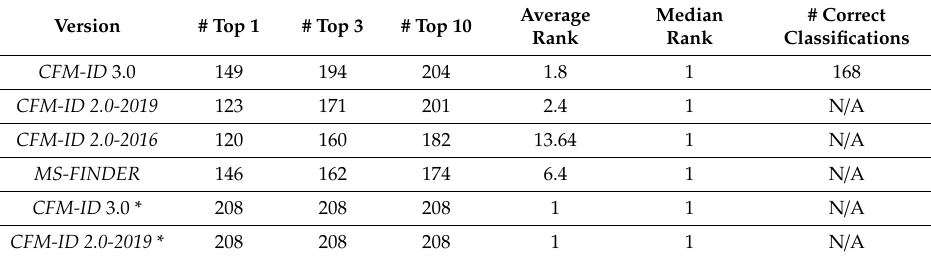
Table 4. Comparison of CFM-ID 3.0, CFM-ID 2.0, and MS-FINDER scoring functions upon identification of 185 compounds from 208 ESI-MS / MS spectra. Reported are the total number of challenges in which the corresponding implementation of the scoring function ranked the query compound in the top 1, top 3, and top 10. The average and median ranks for the query compound are also reported. A chemical classification is assessed as correct if the predicted category matches a category originally assigned by ClassyFire. N / A, not applicable; * performance when applied over the expanded spectral library database including the 208 experimental ESI-MS / MS from the CASMI 2016 contest (category